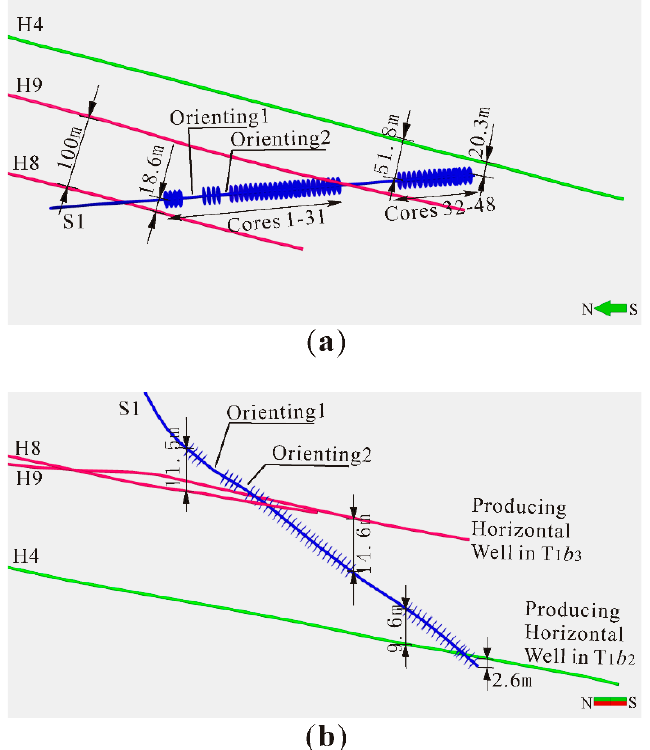
Figure 3. The slant core well trajectory with respect to the adjacent horizontal wells. ( a ) Vertical view; ( b ) side view.